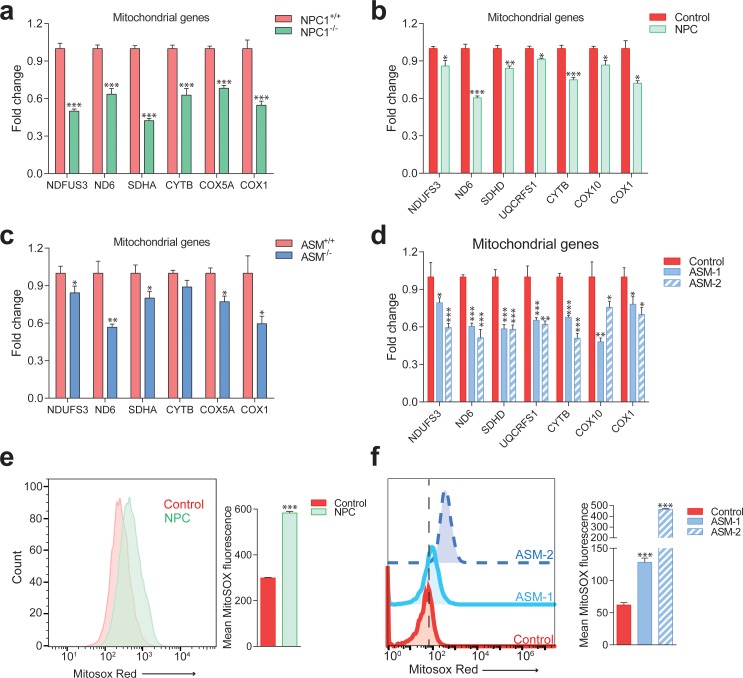
Impaired mitochondrial biogenesis and function in mouse and cellular models of Niemann-Pick disease.The transcript levels of several nuclear-encoded and mitochondrial DNA (mtDNA)-encoded mitochondria-related genes were measured. (a) transcript levels of mitochondria-related genes are decreased in the liver of NPC1 knockout mice (NPC1 KO), a model of Niemann-Pick type C. The plot shows mean ± s.e.m. T-test p-values ***p<0.001, n = 9 (b) transcript levels of mitochondria-related genes are decreased in the fibroblasts of a patient with compound heterozygote NPC1 mutations (GM18398 Coriell Repository). The plot shows mean ± s.e.m. T-test p-values *p<0.05 **p<0.01 ***p<0.001, n = 3 (c) transcript levels of mitochondria-related genes are decreased in the liver of acid sphingomyelinase knockout (ASM KO) mice, a model of acid sphingomyelinase deficiency. The plot shows mean ± s.e.m. T-test p-values *p<0.05 **p<0.01, n = 8. (d) transcript levels of mitochondria-related genes are decreased in fibroblasts from a patient with acid sphingomyelinase deficiency (only 5% of ASM activity left) and in the ASM-2 patient line. The plot shows mean ± s.e.m. T-test p-values *p<0.05 **p<0.01 ***p<0.001, n = 3. Further characterization of the lysosomal defects in the fibroblasts of this patient are presented in Figure 3—figure supplement 1. (e–f) mitochondrial superoxide levels, as assessed by the fluorescence intensity of the superoxide-sensitive mitochondria-targeted dye MitoSox, measured by flow cytometry, are increased in NPC fibroblasts (panel e) and in ASM-1 and ASM-2 patient fibroblasts (panel f); histogram plots are representative of three biological replicates. Quantifications denote mean ± s.e.m..T-test p-values ***p<0.001, n = 3.